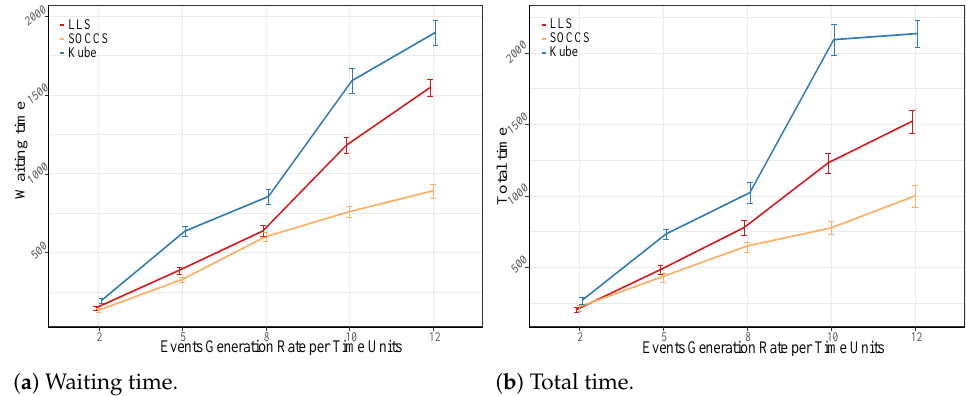
Figure 14. Time metrics for all the scheduling algorithms.